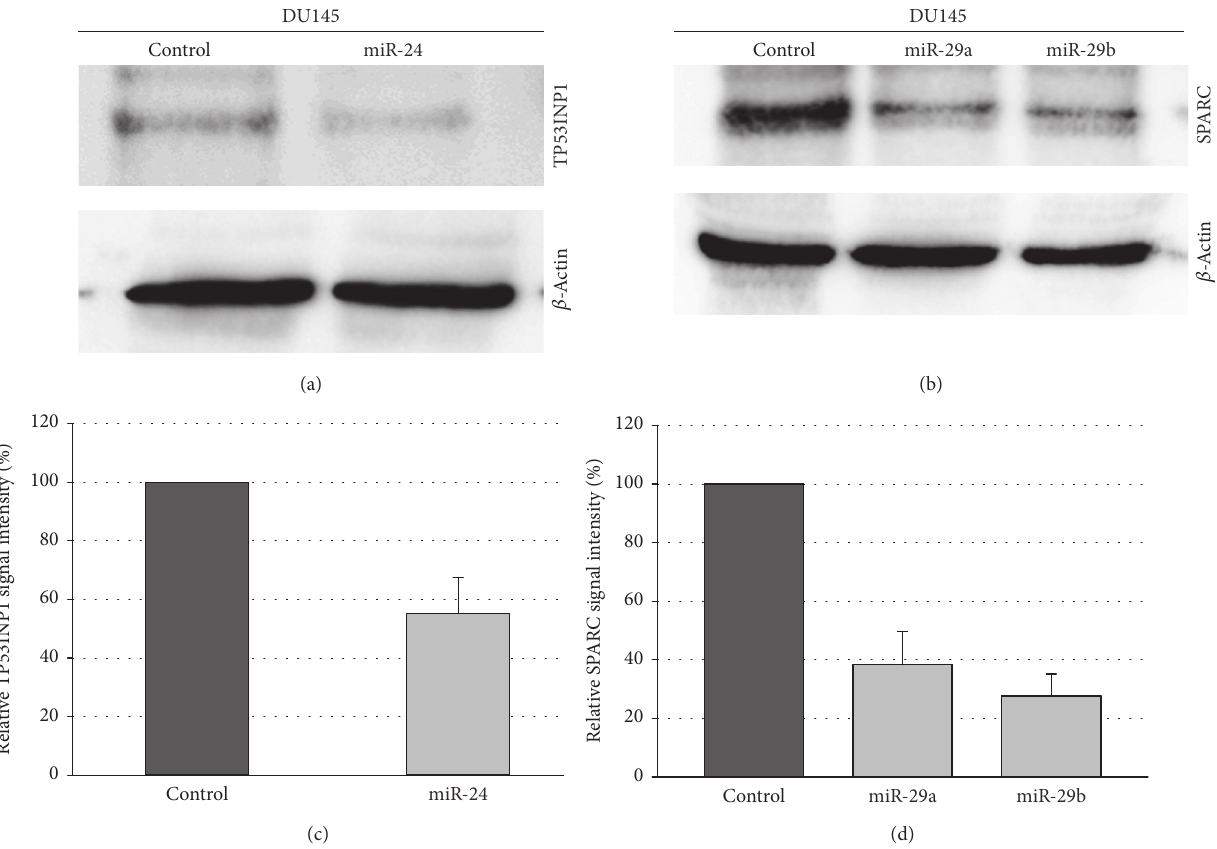
Figure 5: Regulation of TP53INP1 and SPARC protein expression by miR-24 and 29a/b. DU145 cells were transfected either with control vectors or miRNA expression vectors. 48 hours after transfection, the protein expression of (a) TP53INP1 and (b) SPARC was determined by western blot using 𝛽 -actin as loading control. The quantification of the western blots in (c) and (d) represents the relative downregulation as determined in three independent experiments using 𝛽 -actin as loading